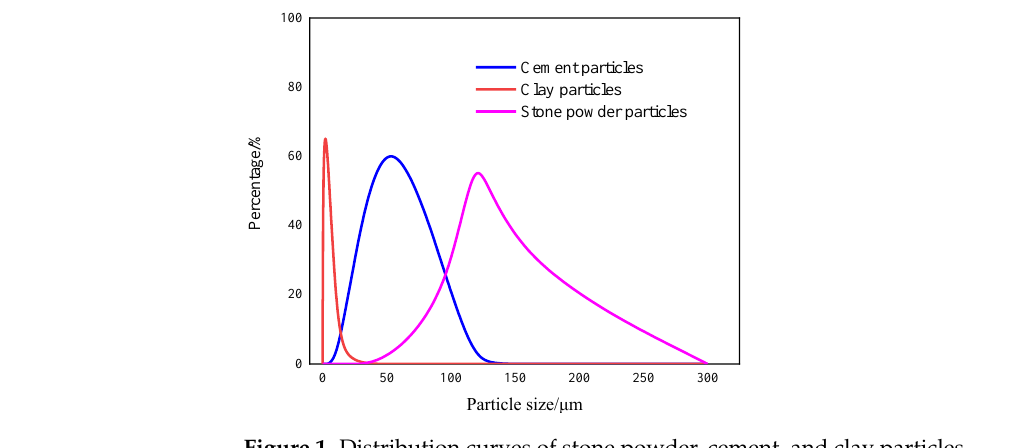
Figure 1. Distribution curves of stone powder, cement, and clay particles. Table 7. Slurry material mix